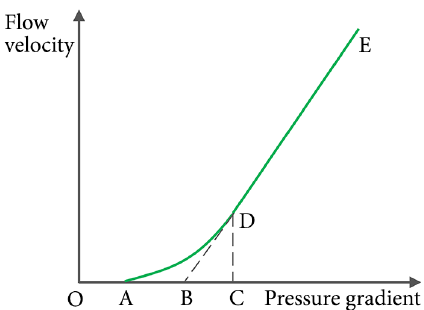
Figure 1. Schematic diagram of nonlinear seepage characteristics of low permeability reservoir